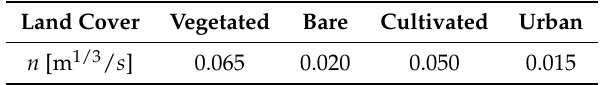
Table 1. Manning coefficient of the different soil types [50,51].